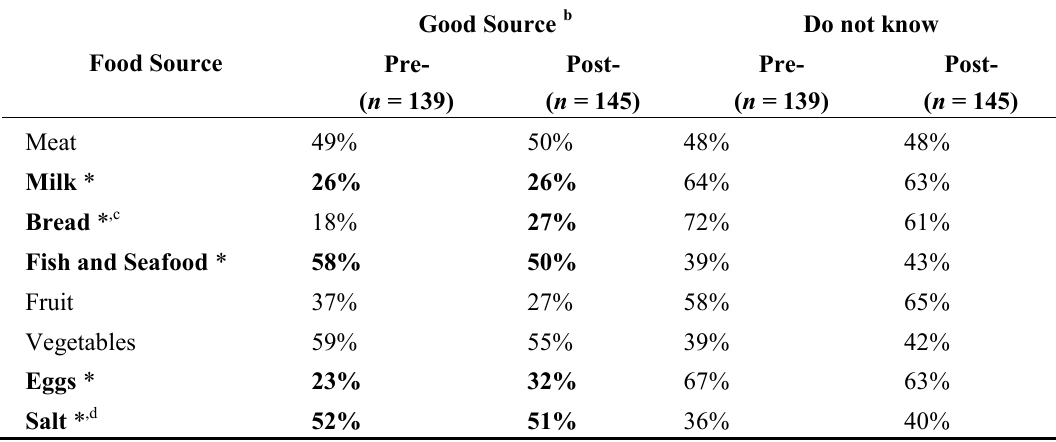
Table 2. Knowledge about iodine in pregnant women pre- and post-fortification (response to question: ―Which foods are good sources of iodine in the Australian diet?‖) a .